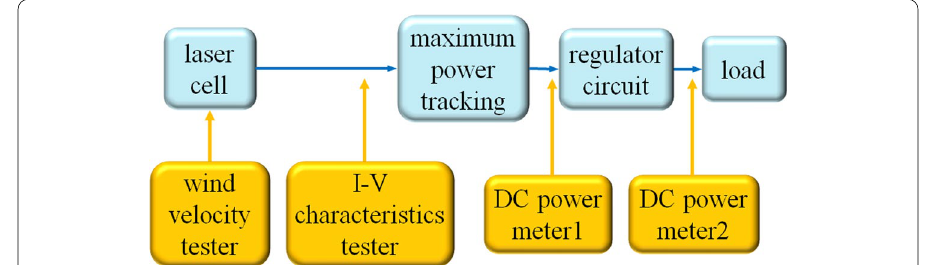
Fig. 6 Receiver side battery component test set-up